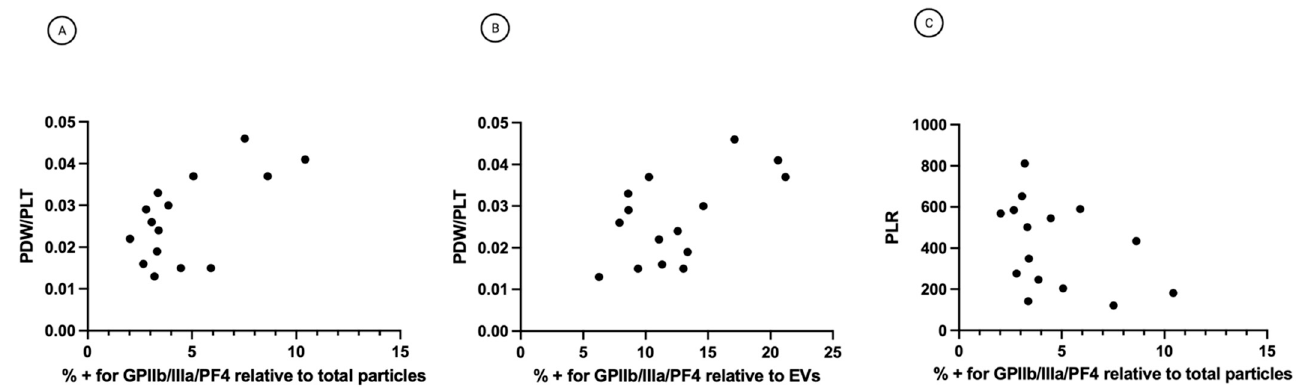
Figure 5. ( A ) Correlation between percentage of platelet biomarkers relative to total particles and PDW/PLT. r = 0.6307, p = 0.0117 ( B ) Correlation between percentage of platelet biomarkers relative to EVs and PDW/PLT. r = 0.5832, p = 0.0225. ( C ) Correlation between percentage of platelet biomarkers relative to total particles and PLR. r = − 0.4177, p = 0.1274. PDW = platelet distribution width; PLT = platelet count; PLR = platelet to lymphocytes ratio.